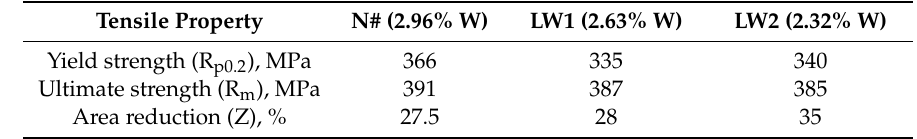
Table 3. Tensile properties of three 9Cr-3W-3Co steels at 650 ◦